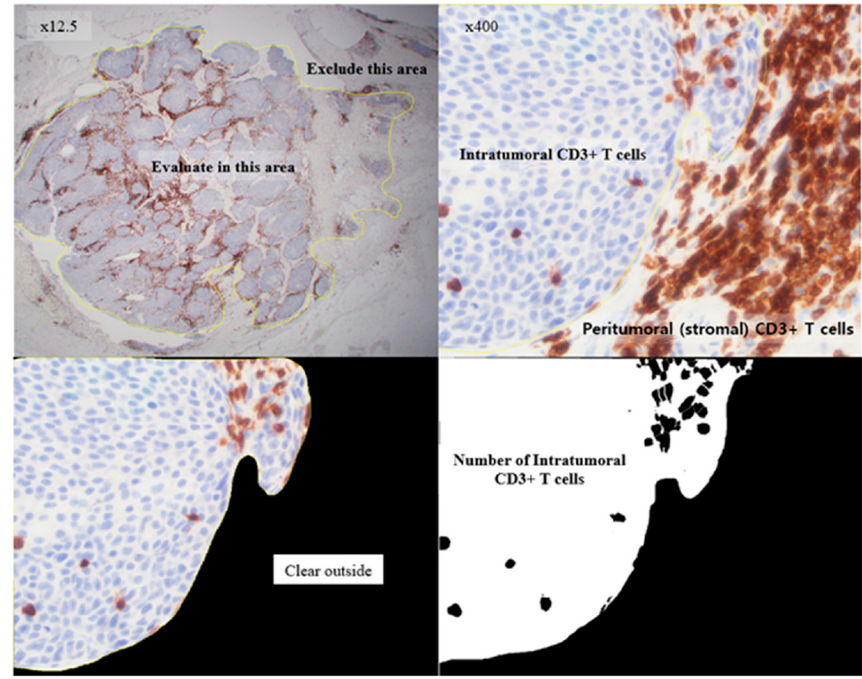
Figure 4. Counting of intratumoral CD3+ T cells using the ImageJ software.